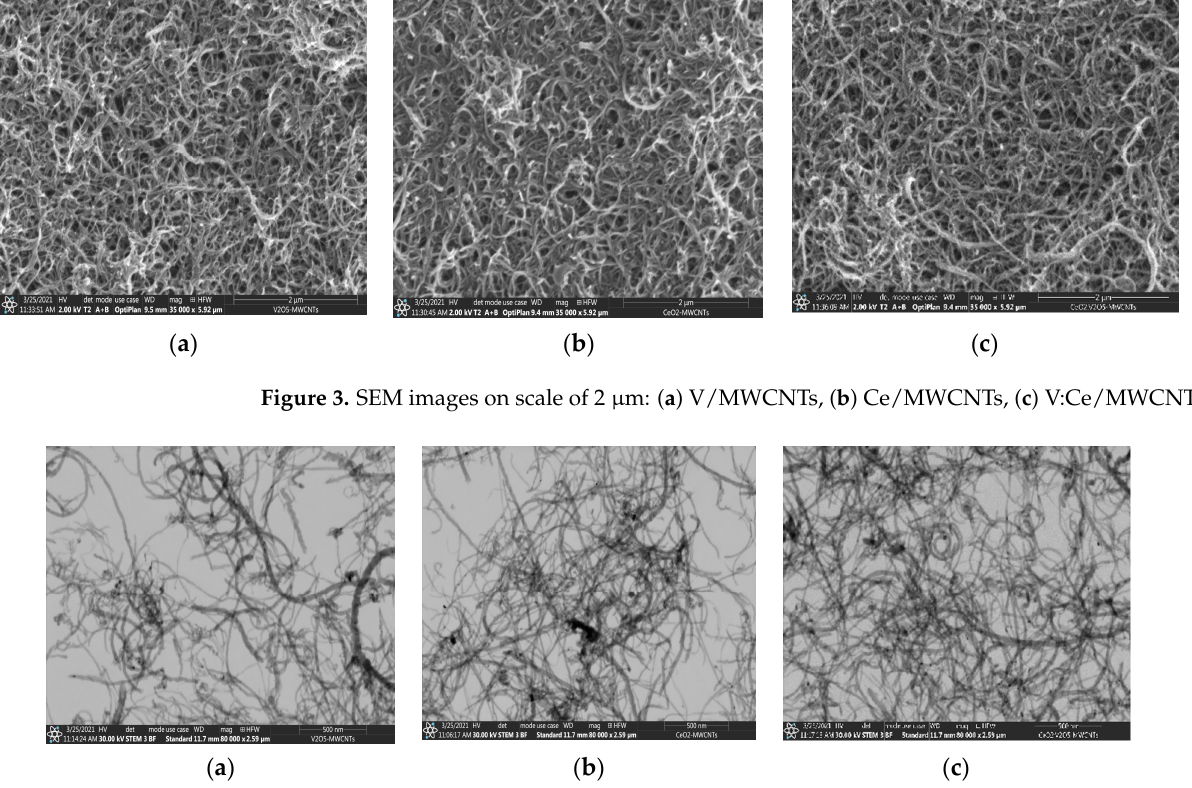
Figure 4. TEM images on a scale of 500 nm: ( a ) V/MWCNTs, ( b ) Ce/MWCNTs, ( c ) V:Ce/MWCNTs. EDX results were recorded to determine the amount of carbon, vanadium and/or cerium on the surface of the samples. The analysis was carried out on three areas of the specimens and the average measured compositions of the near-surface layer of the samples are presented in Table 1. The compositions of the V/MWCNTs and V:Ce/MWCNTs samples estimated by EDX analysis were in good agreement with the theoretical values used for preparation. Higher amounts of cerium dioxide than expected were detected in the Ce/MWCNTs samples. The EDX results support the notion that metal oxides were deposited on the surface of the carbon nanotubes.